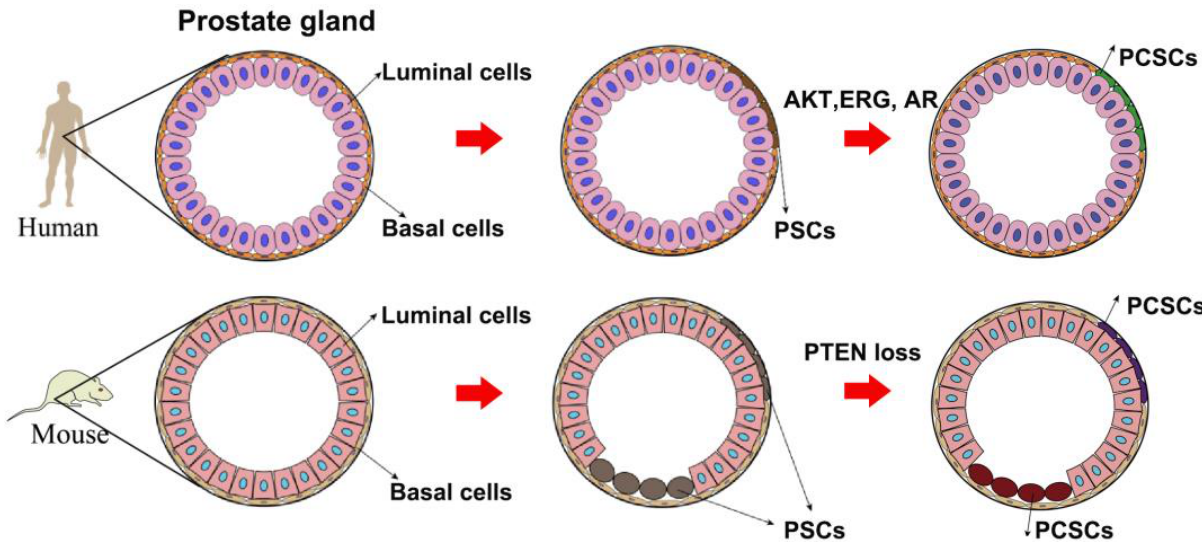
Figure 1. A model of the origin of prostate cancer stem cells.